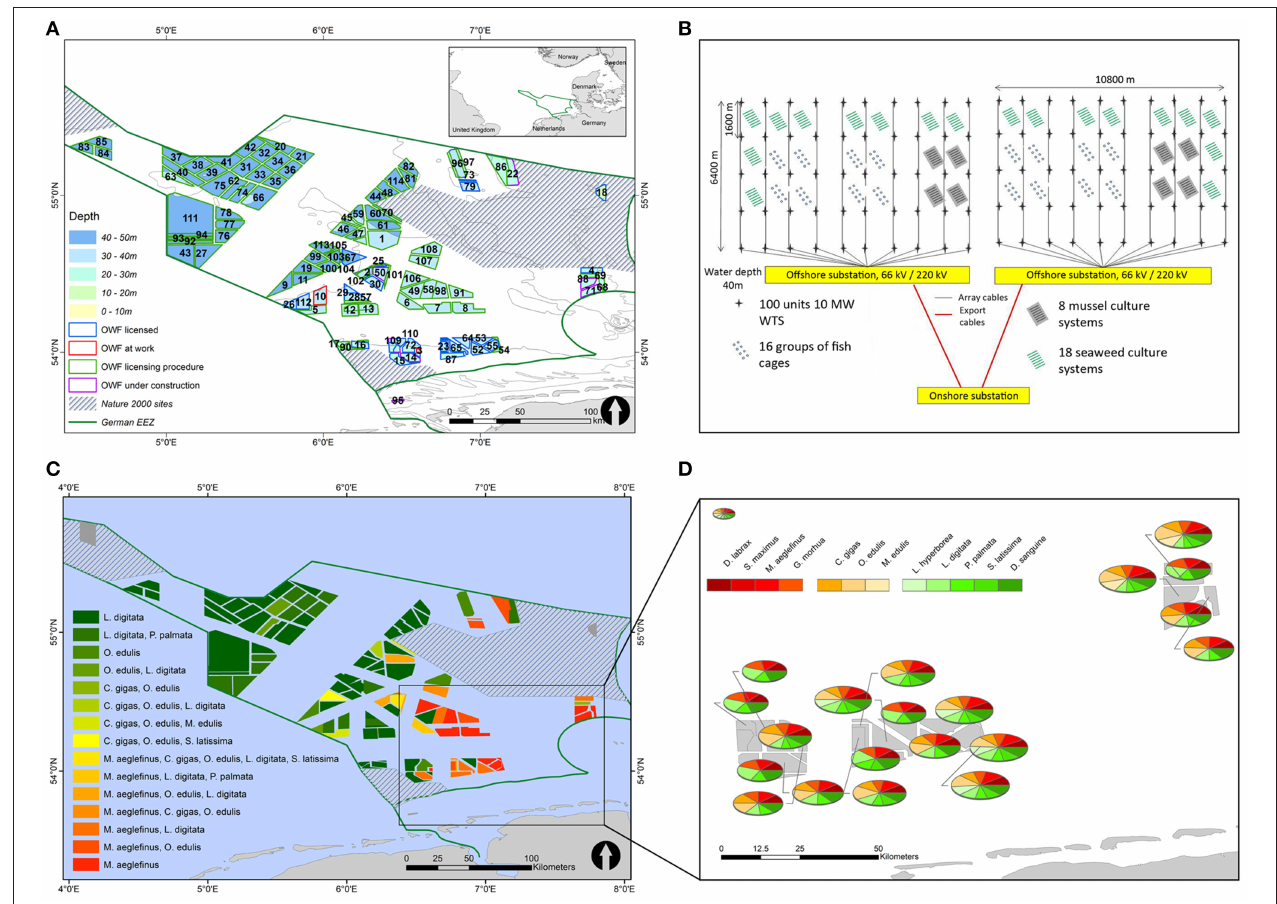
FIGURE 3 | (A–D) Offshore multi-use set-ups with wind farms and IMTA. (A) shows a map of all German offshore wind farms within the EEZ of the German Bight, numbered, colored per depth level and framed per status. Shaded districts show the Nature 2000 areas (upper left). (B) SINTEF - Statoil IMTA design for the North Sea (upper right); (C) displays a map of suitable co-location sites in the German EEZ of the North Sea, colored per aquaculture candidate featuring the highest suitability per wind farm area (lower left) with the enlargement (D) closer to the German coast (North Sea). Results presented depict the conditions given at 10–20m depth during spring time (lower right). The size of the pies reflects the height of the relative suitability scores [Images (A,C,D) with permission of the publisher modified after ( Stelzenmüller et al., 2017); (B) with permission of the publisher modified after (Buck et al., 2017b; He et al.,